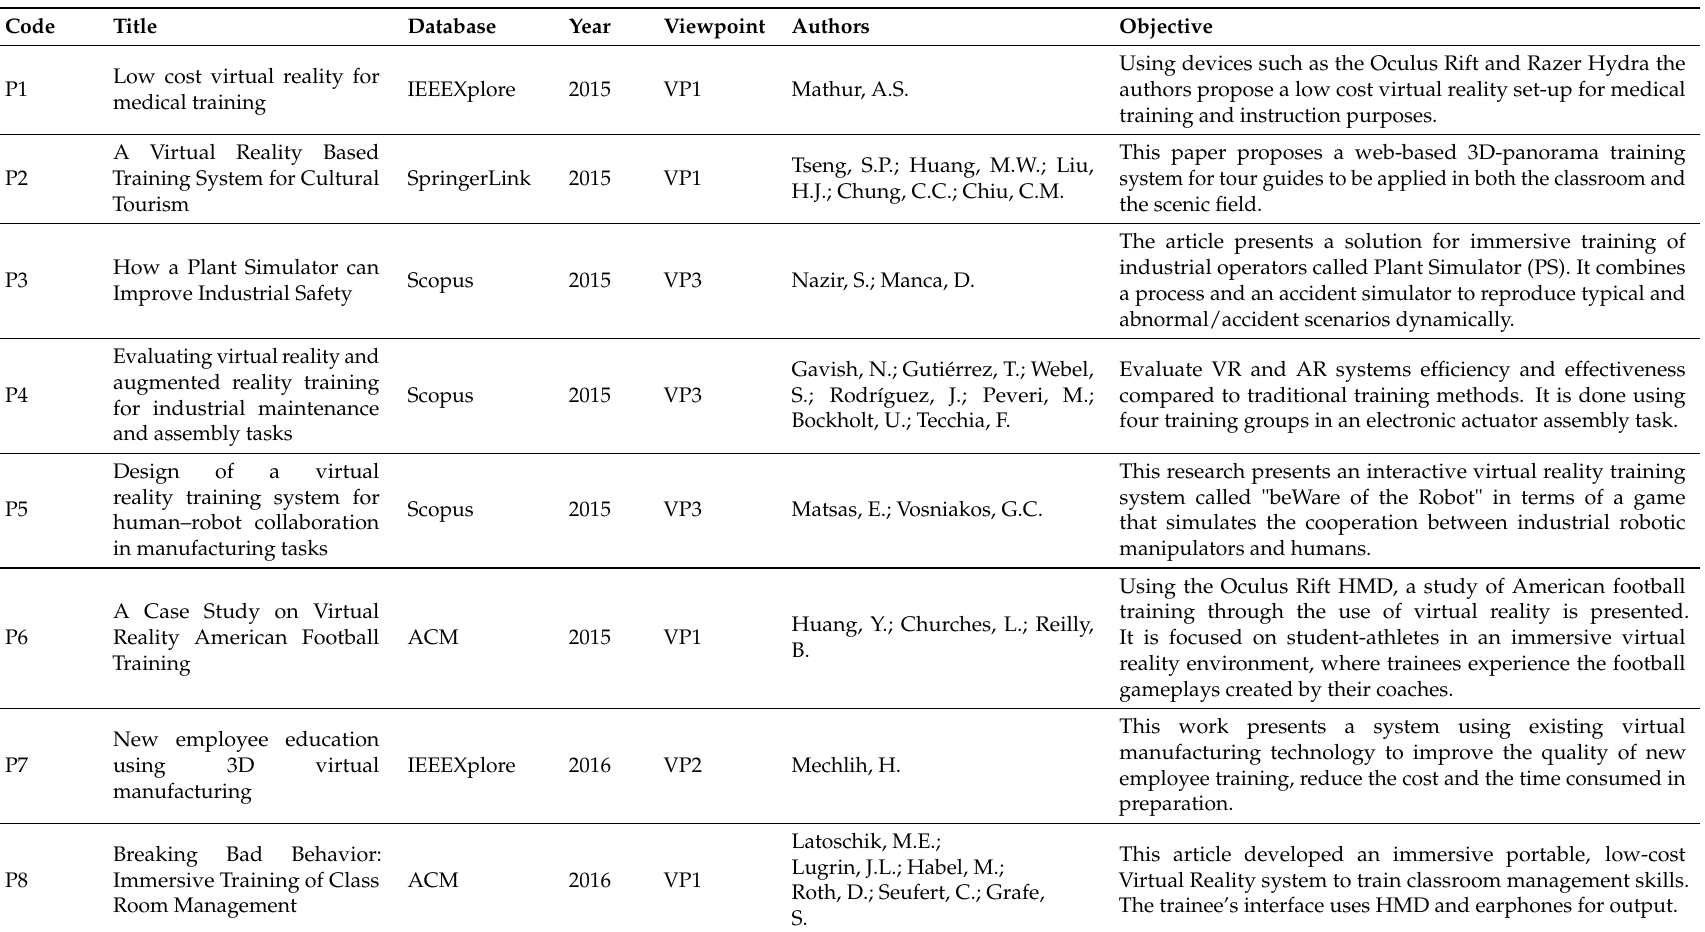
Table 3. Selected papers